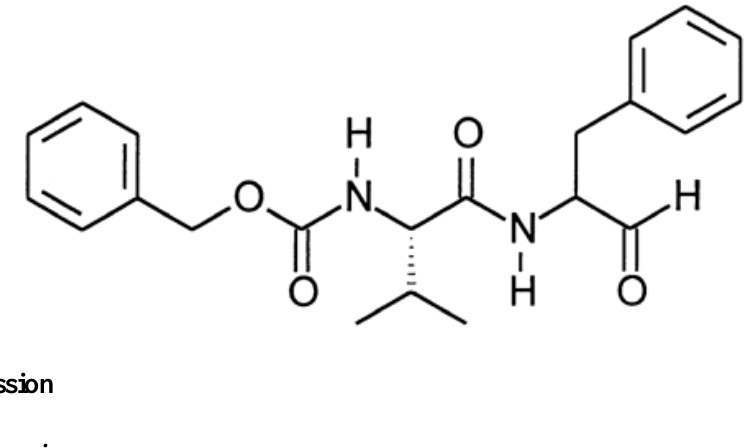
Figure 1. Chemical structure of MDL 28,170 ( N